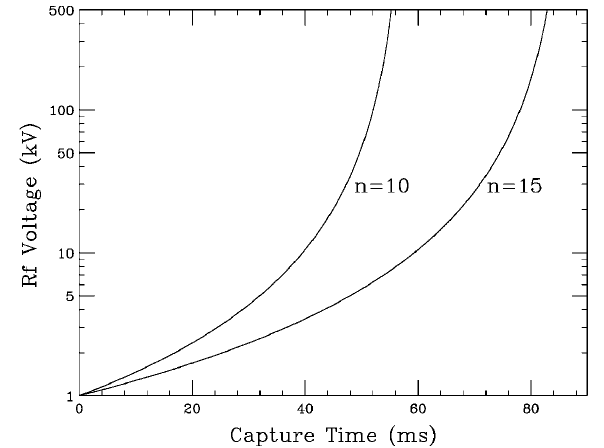
FIG. 10. Plot of capture time in ms for various initial and final rf voltages V 1 and V 2 (cid:1) 500 kV. The relative rate of change of the bucket area is taken as 1 (cid:1) n of the angular synchrotron frequency, where n (cid:1) 10 or 15.